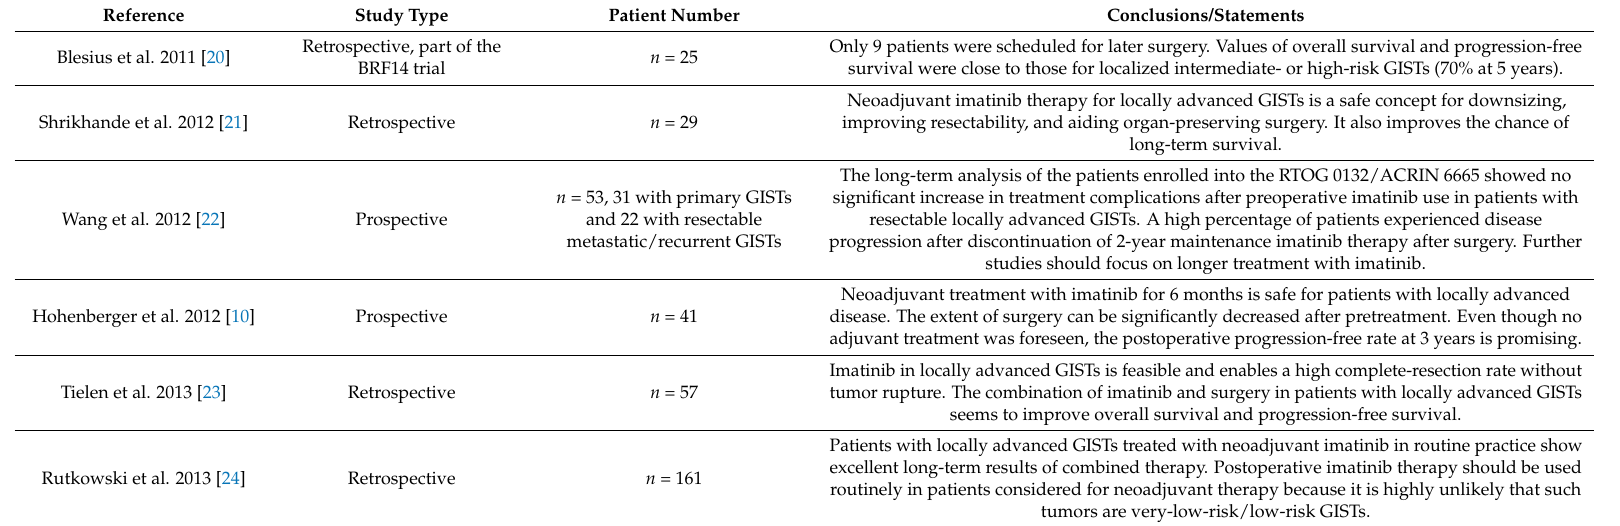
Table 4. Summary of relevant studies on neoadjuvant imatinib